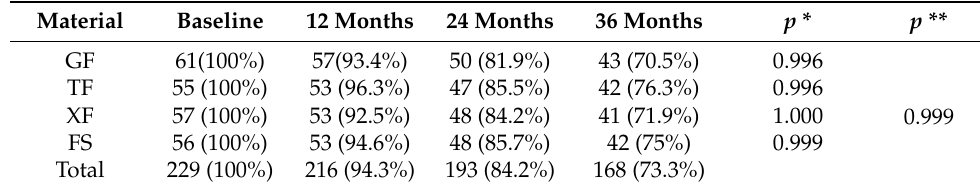
Table 3. Recall rates.